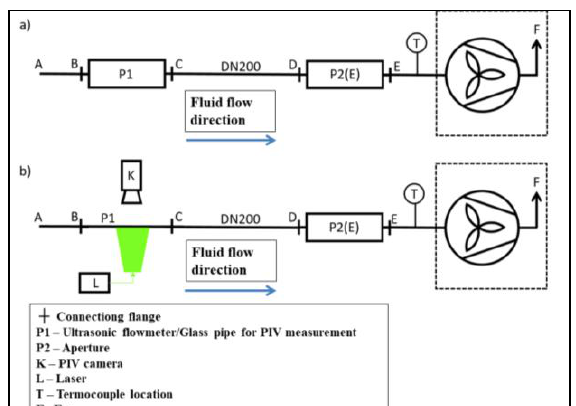
Fig. 15. Schema of the experimental line.